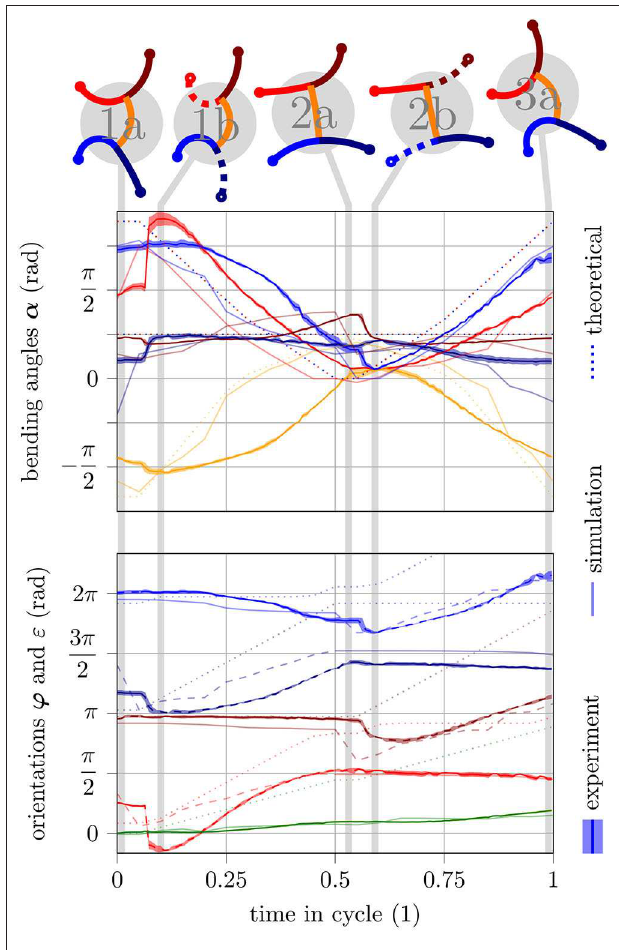
FIGURE 6 | Simulation and experiment of one gait cycle for q = [80 ◦ − 0.5] and c 1 = 1. Theoretical values (according to the gait law) are illustrated with light dotted lines. Simulated values are illustrated with light solid lines. Experimental values are illustrated as solid lines together with an area indicating the standard deviation. In the orientation plot and the poses shown above, lines representing unfixed feet/legs are illustrated as dashed lines. The switch of fixation happens at half cycle time. Color code as follows: front left leg (red), front right leg (dark red), torso (orange), rear left leg (blue), rear right leg (dark blue), robot orientation (green).